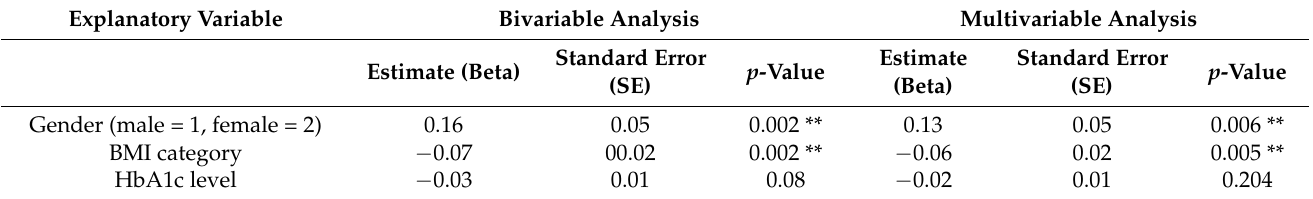
Table 5. Bivariable and multivariable linear regression analyses examining factors associated with HDL level ( n =